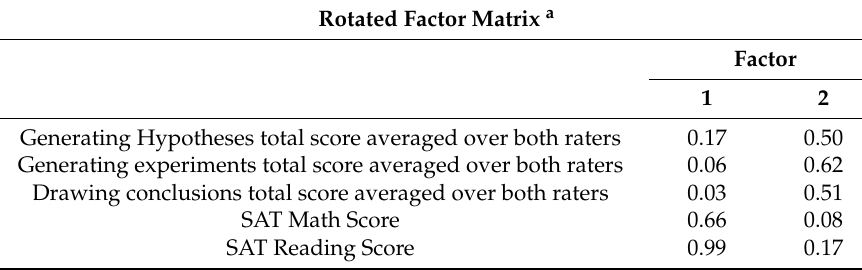
Table 15. Rotated maximum likelihood common factor analysis with SAT.